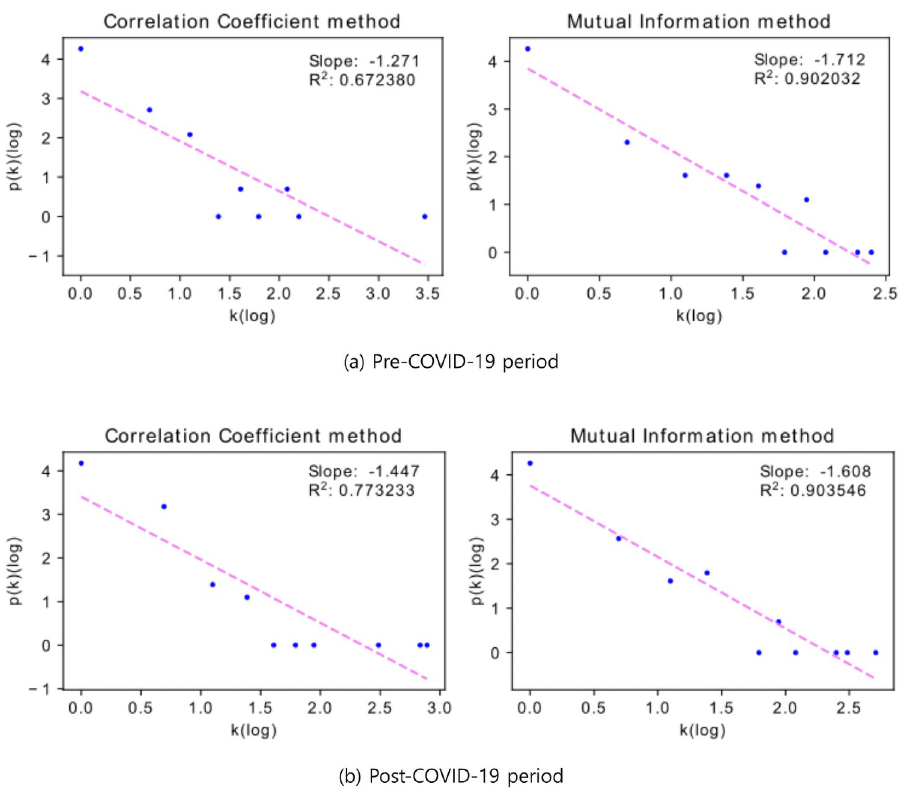
Fig 8. Distribution of nodes’ degrees for the MSTs during pre- and post-COVID periods.